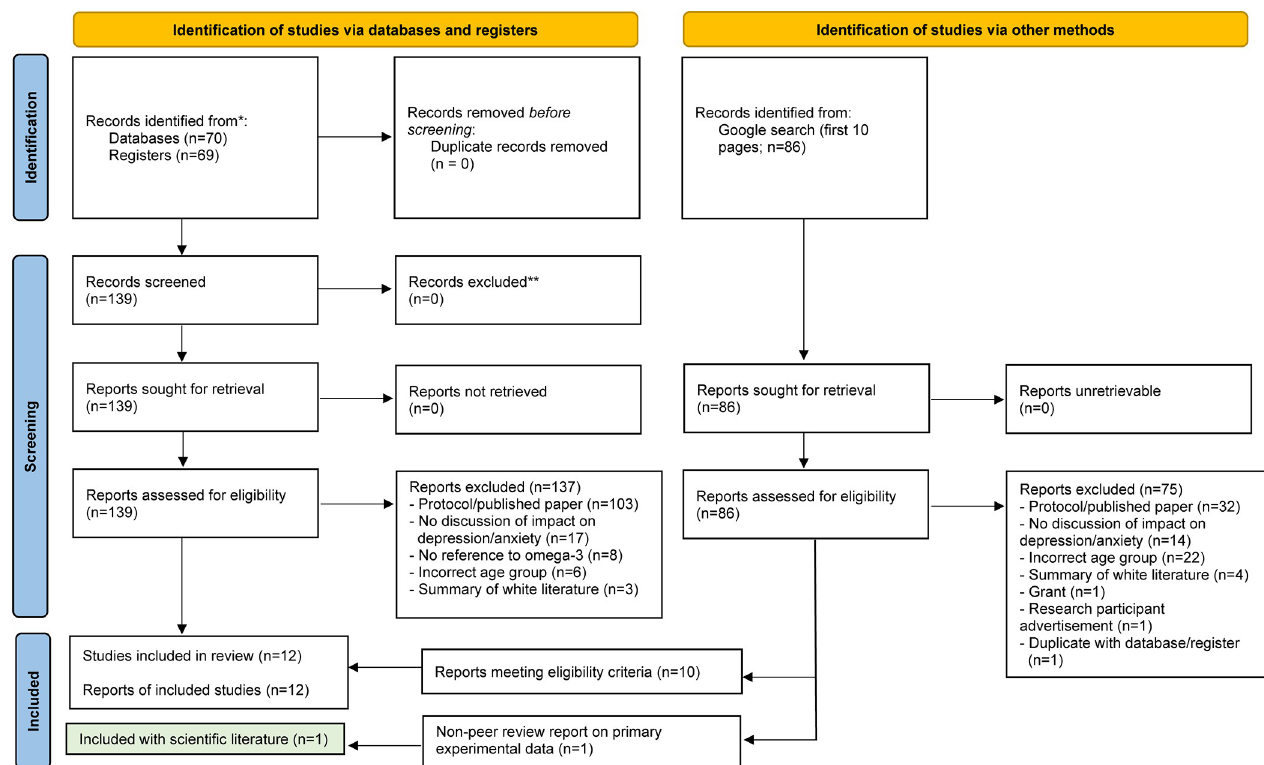
Fig 2. PRISMA flow diagram: Grey literature screening